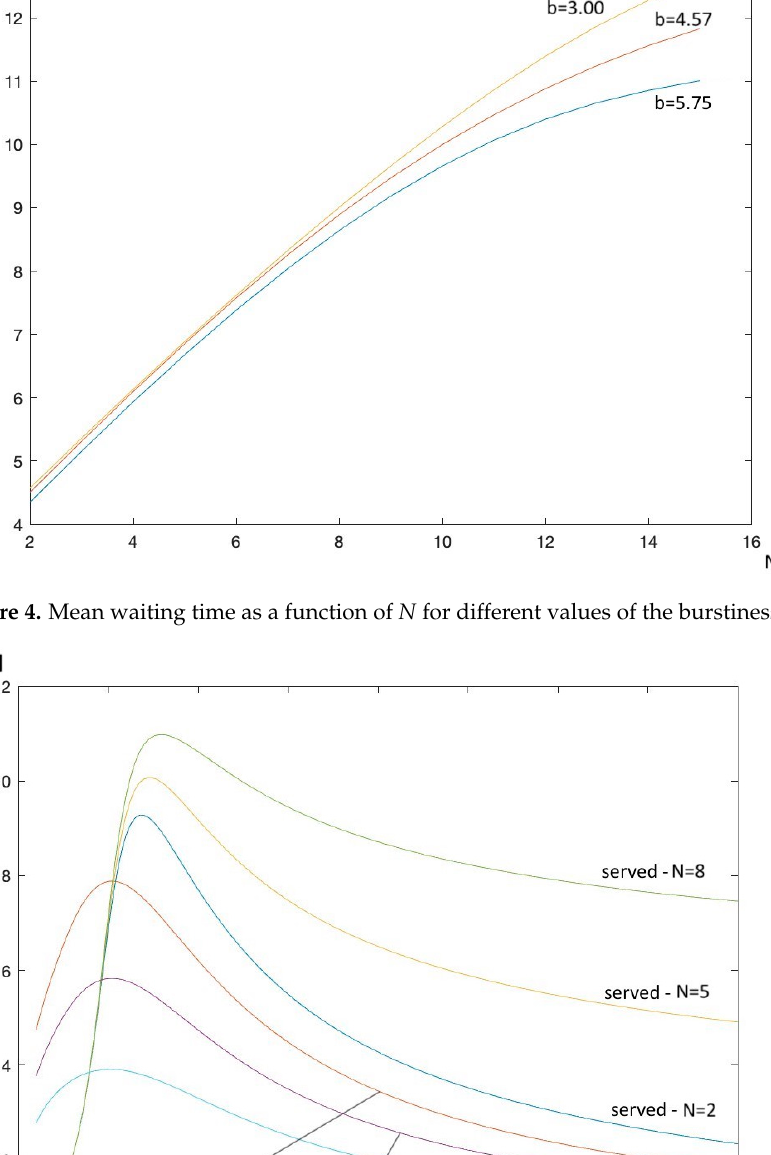
Figure 4. Mean waiting time as a function of 𝑁 for different values of the burstiness of the input.